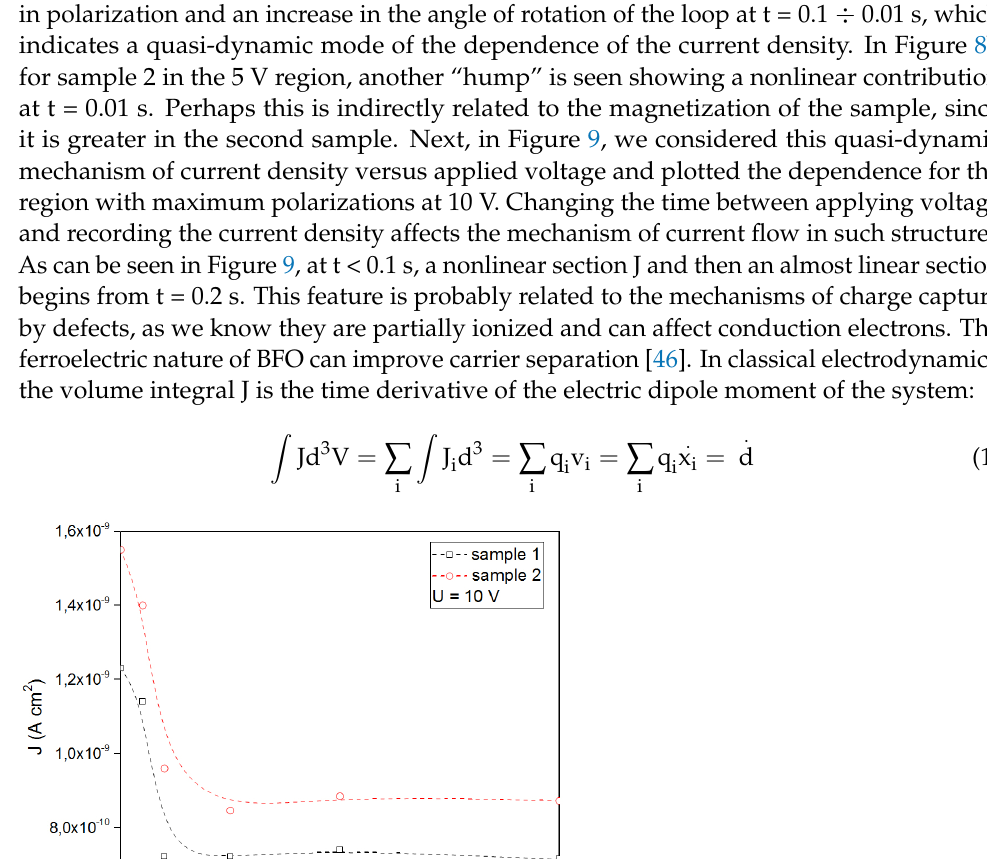
( b ) Figure 10. Magnetic hysteresis loops M (H) for BFO/polyimide samples at ( a ) 300 K and ( b ) 200 K. Taking into account the volume of the film thickness for sample 2 M max = 0.31 emu/cc, this value of magnetization is practically comparable with the BFO antiferromagnetic ce- ramics [49]. The appearance of magnetic hysteresis at room temperature indicates the an- tiferromagnetic properties of the obtained films (Figure 10). The paramagnetic component is also seen, the substrate exhibits the properties of a diamagnet as seen in Figure 10a. A ferromagnetic phase associated with Fe − Fe exchange interactions already appear in sam- ple 2, the low magnetization (4.6 × 10 − 6 emu) can be attributed to the ferrimagnetic nature